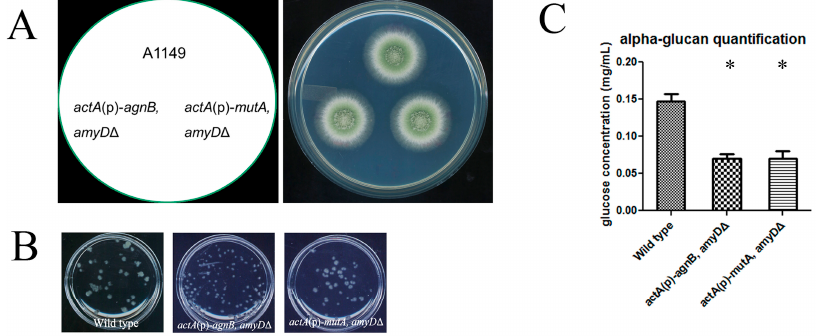
Figure 4. The absence of AmyD cannot suppress the increased α -glucan production of agnB - or mutA -overexpression strains. ( A ) All constructed strains showed the wild-type colony phenotype on solid medium; ( B ) all strains behaved the same as the wild-type; and ( C ) α -glucan was extracted from 1 mg of dry cell wall, and then digested to glucose and quantified using an anthrone assay. Results represent the mean of three independent quantification tests with duplicates each time ± standard deviation. The data for each strain were compared with wild type (column 1) individually by a Mann Whitney U test. Significant difference ( p < 0.05) was indicated by asterisks.